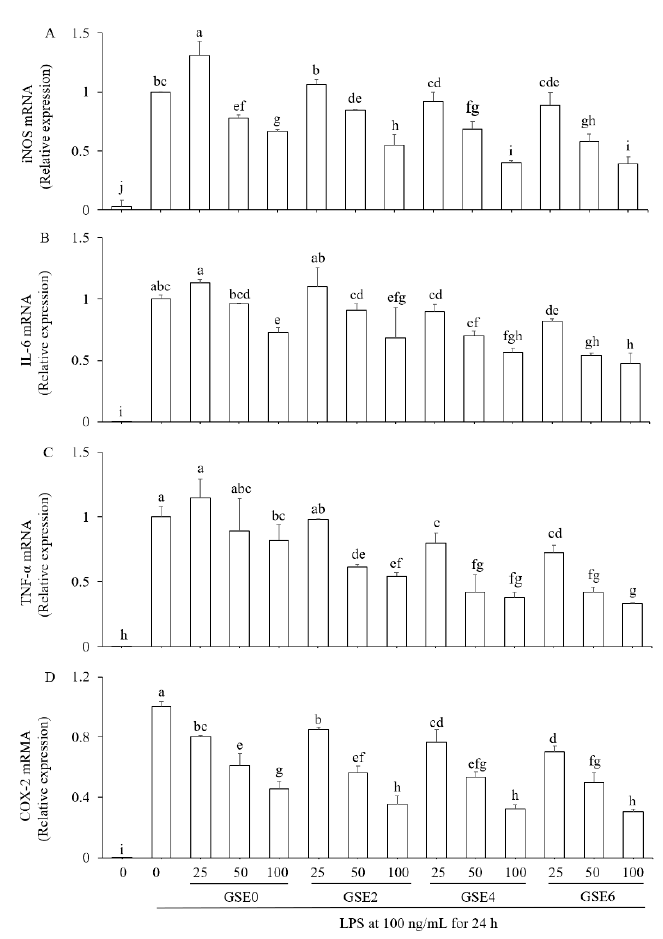
Figure 5. Inhibitory e ff ects of GSEs steamed for di ff erent times (0–6 h) on relative mRNA expression of four pro-inflammatory factors in LPS-induced RAW264.7 cells. Cells were incubated with GSE0, GSE2, GSE4, GSE6 (25, 50, or 100 µ g mL − 1 ), or vehicle for 2 h and then treated with 100 ng mL − 1 LPS at 37 ◦ C. After a 24-h treatment with LPS, the mRNA expression levels of inducible nitric oxide synthase (iNOS) ( A ), IL-6 ( B ), TNF- α ( C ) and cyclooxygenase-2 (COX-2) ( D ) were determined using qRT-PCR and normalized to GraPDH levels. The results shown here are representative of three independent experiments and are presented as means ± SD. Di ff erent letters indicate significant di ff erences at p < 0.05 based on Duncan’s multiple range